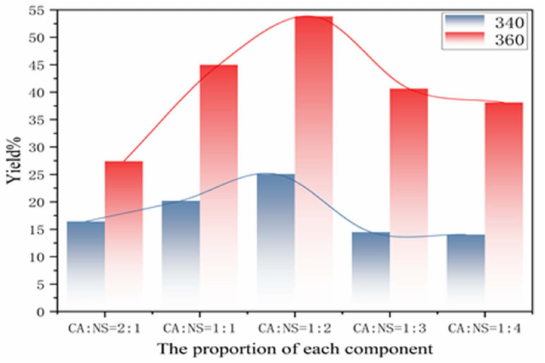
Figure 4. Variation in fluorescence yield in each component at excitation wavelengths of 340 and 360